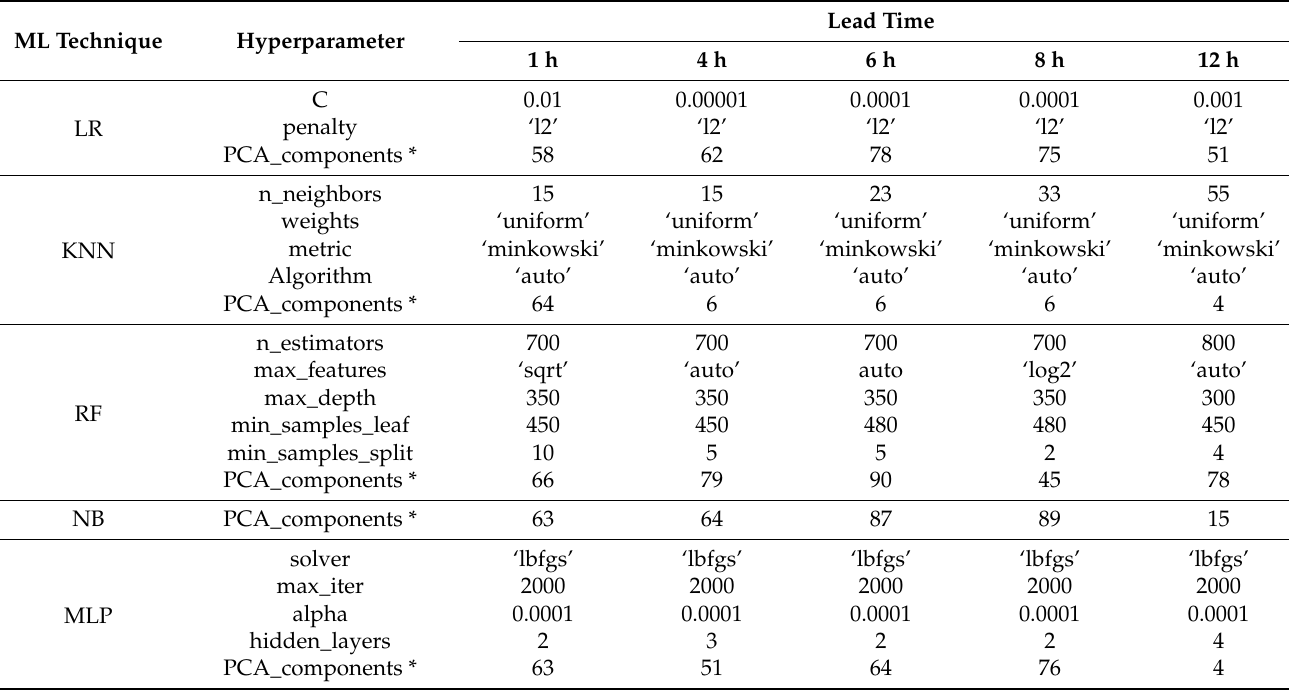
Table 3. Model hyperparameters and number of principal components used for each specific model (ML technique and lead time). ML